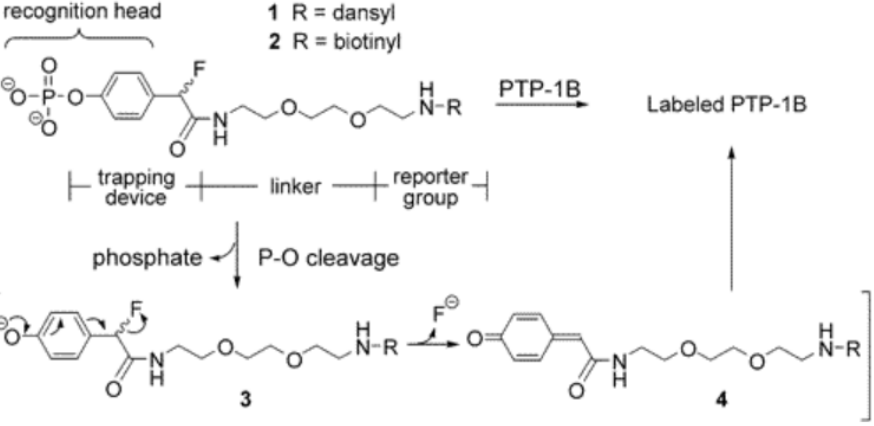
Figure 3. The structure of LCL-1 and LCL-2 and the mechanism of substrate cleavage. Reprinted with permission from [30], copyright 2002 American Chemical Society.